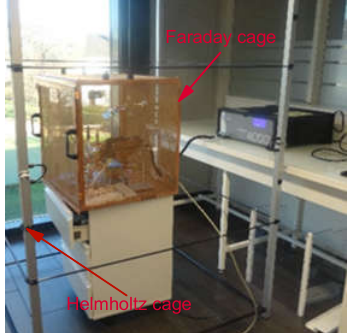
Figure 4. The microelectrode protected by the Faraday and Helmholtz cages.